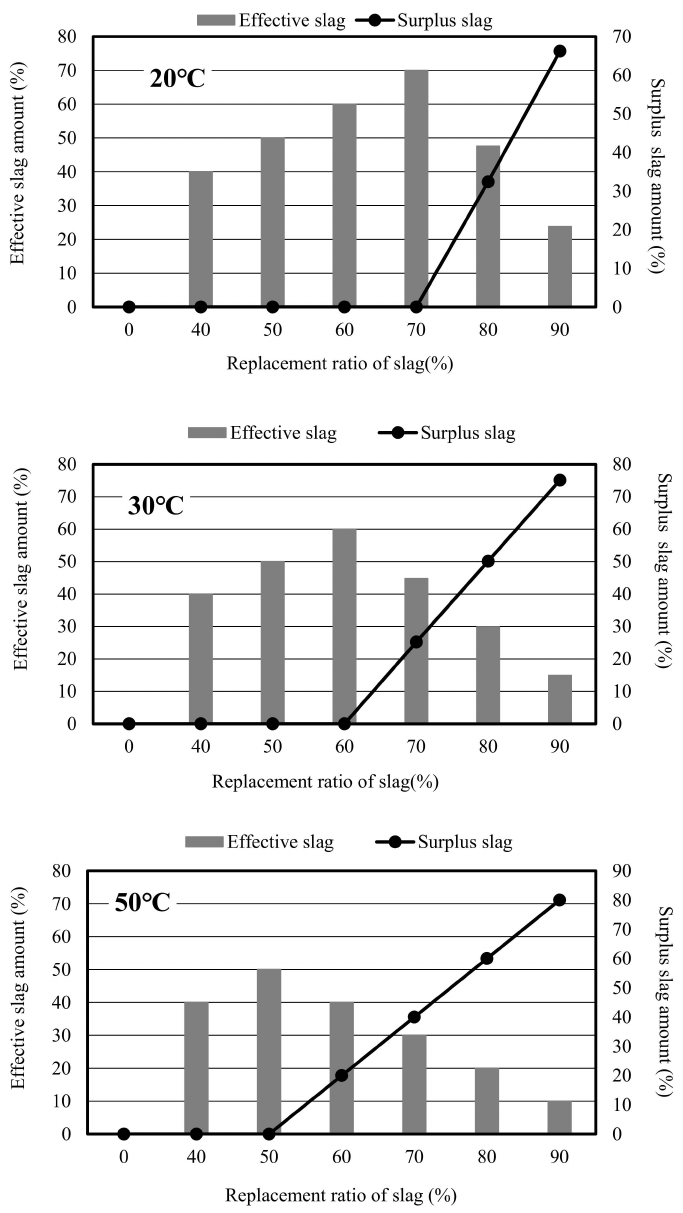
Figure 9. E ff ective slag amount and surplus slag amount in